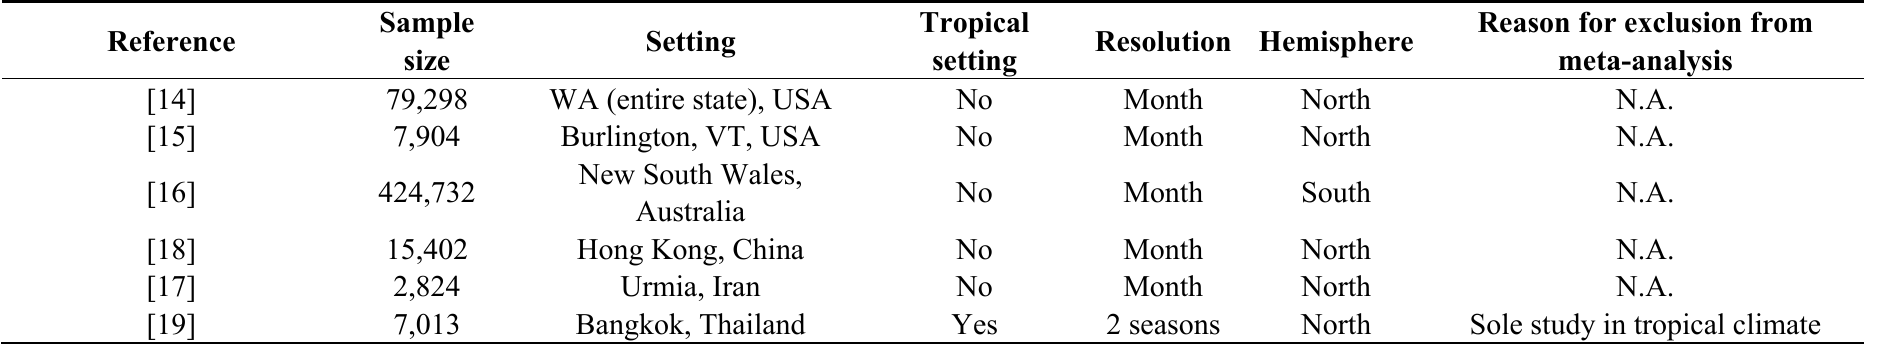
Table A1. Studies examined for the meta analysis of the influence of month of conception on preeclampsia incidence.